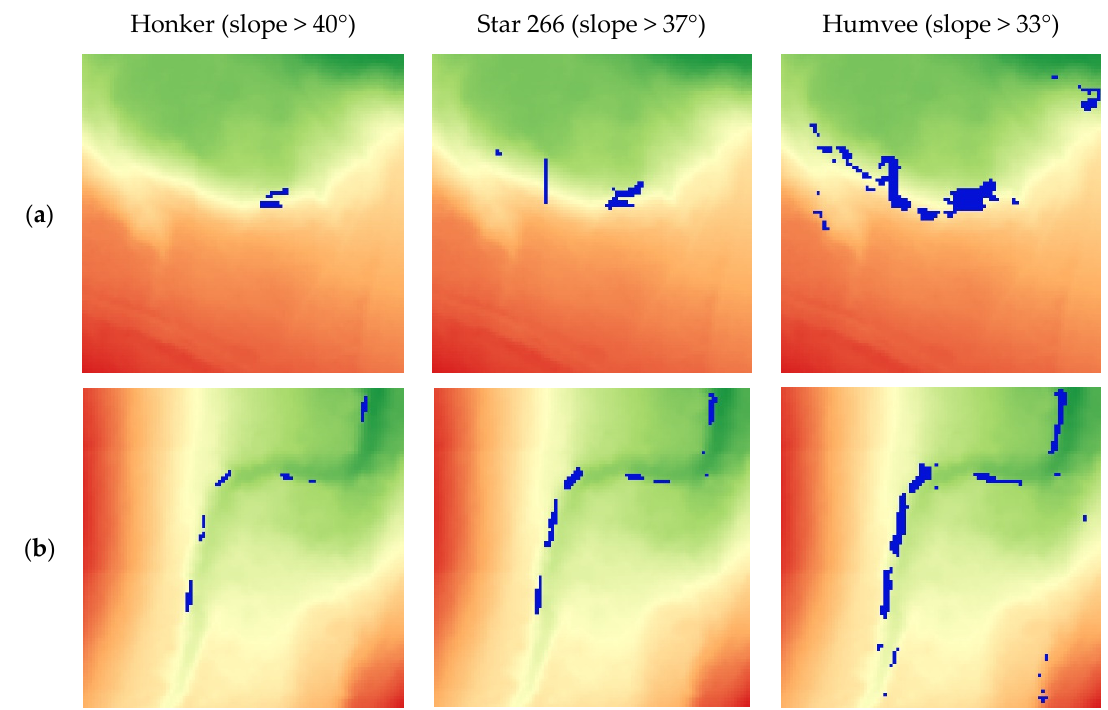
Figure 5. DEMs with indicated impassable areas due to the slope angle: ( a ) bluff terrain, and ( b ) stream terrain.